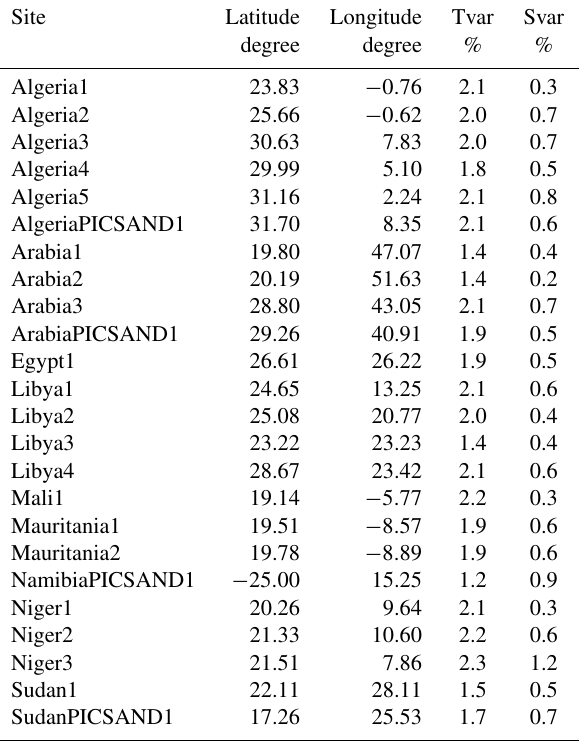
Table 1. Alphabetical list of Saharan PICS from Bacour et al. (2019) with latitude and longitude following updated coordinates. Time variability and spatial homogeneity are given for reference.